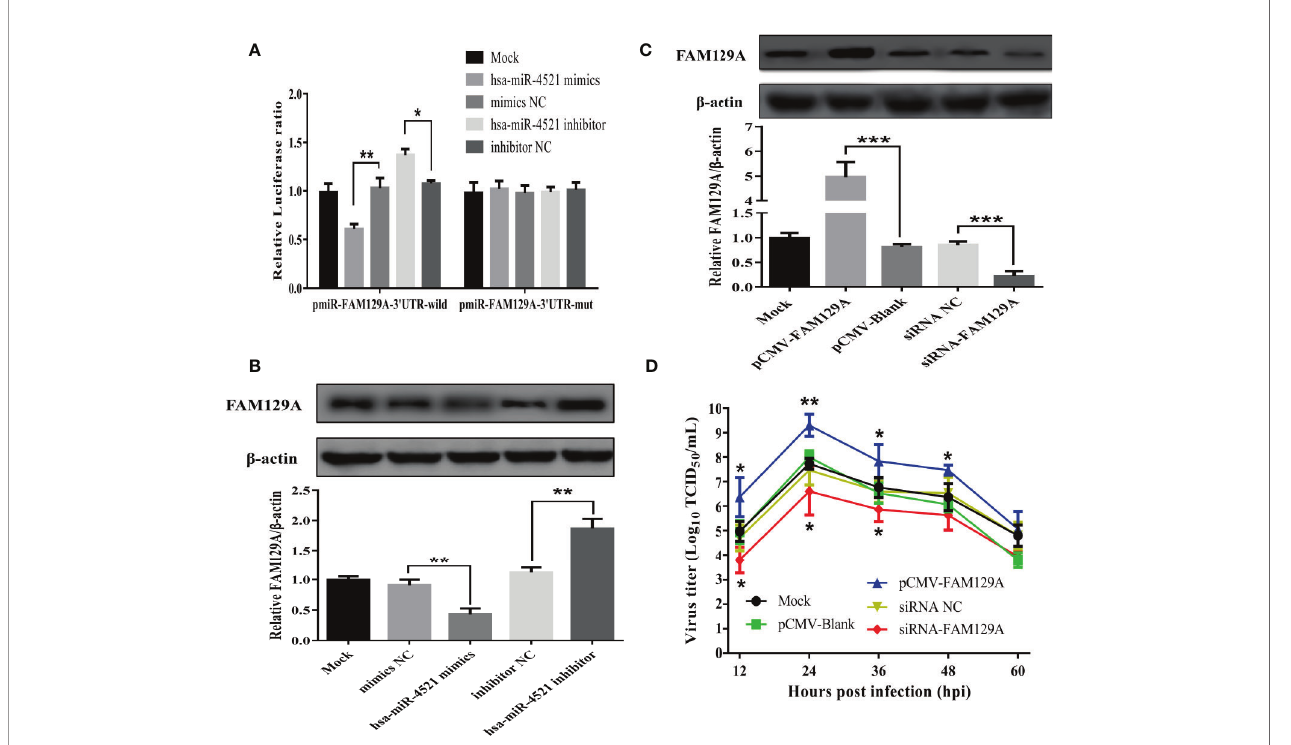
FIGURE 8 | FAM129A was directly targeted by hsa-miR-4521 and positively regulated NDV replication in HeLa cells. (A) HeLa cells were co-transfected with indicated miRNA oligonucleotides and plasmids, and renilla luciferase activity was measured and normalized to fi re fl y luciferase activity after 48h. (B, C) The expression of FAM129A protein in HeLa cells was detected by Western blot assay at 18h after indicated miRNA oligonucleotides (B) or plasmids (C) were transfected and the relative intensity of FAM129A was normalized to b -actin and showed in the below. (D) HeLa cells were transfected with indicated plasmids or siRNAs, eighteen hours after transfection, cells were infected with Herts/33 at an MOI of 1 and the viral growth curves were measured by detecting virus titers in the supernatant collected at indicated time points. Data are from three independent experiments and presented as the means ± SD. *stands for P -value < 0.05, **stands for P -value < 0.01 and *** stands for P -value <